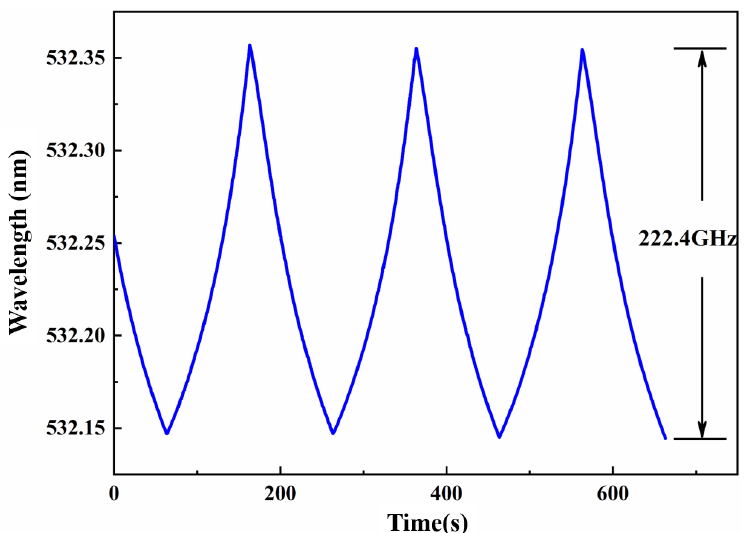
Figure 16. Schematic diagram of super broadband tunable single-frequency CW laser [30]. c (cid:13) [2021] IEEE. Reprinted, with permission, from [30].